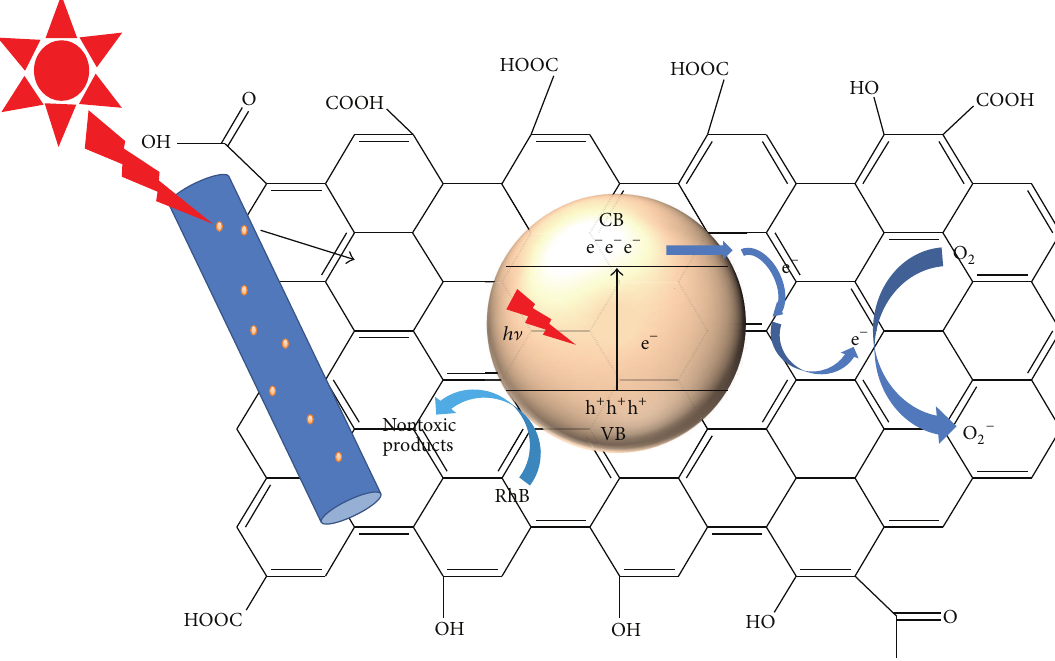
Figure 7: A conceptual mechanism about the graphene oxide/BiOCl heterostructured nanofibers (the specified example in this study) for visible-light photocatalytic enhancements of CO 2